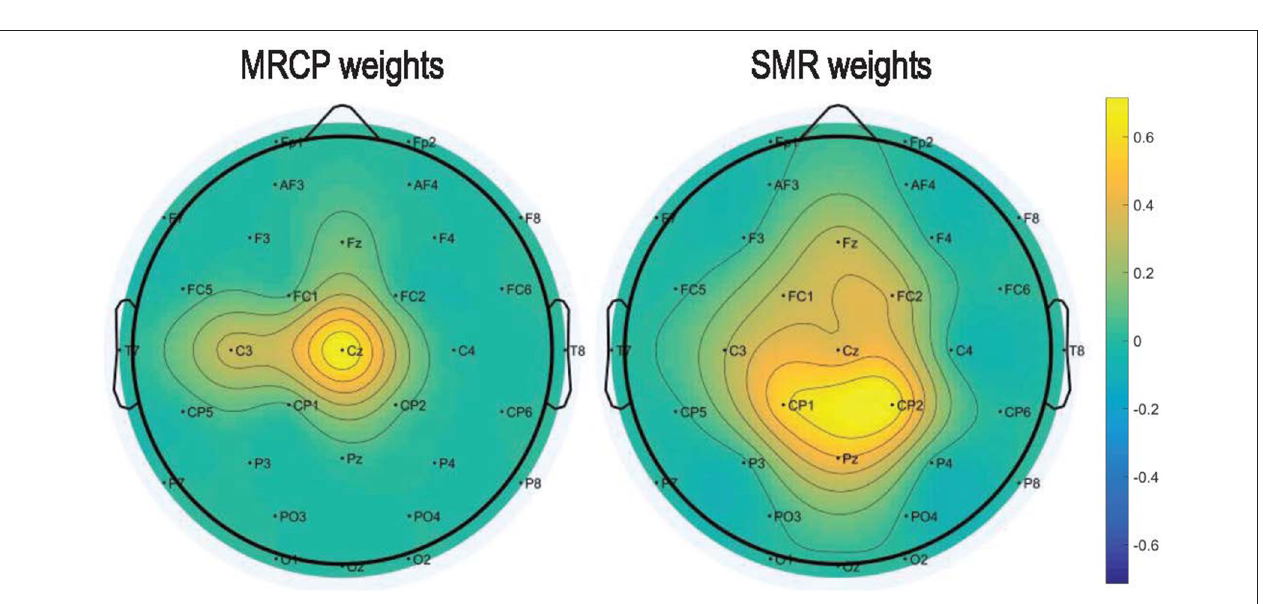
FIGURE 7 | Topographic maps to show the normalized DP index of each channel averaged across all subjects and conditions. The weights were assigned by the modified CVA for the MRCP-based and SMR-based